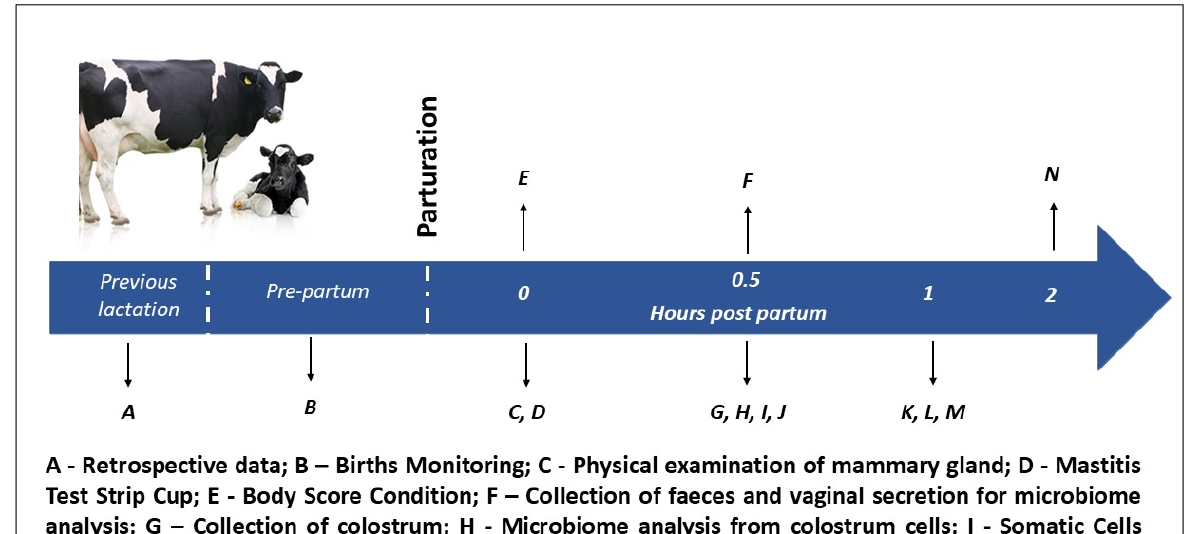
Figure 1. Timeline indicating the order and timing of observations, sample collections and interventions carried out during the course of the study.